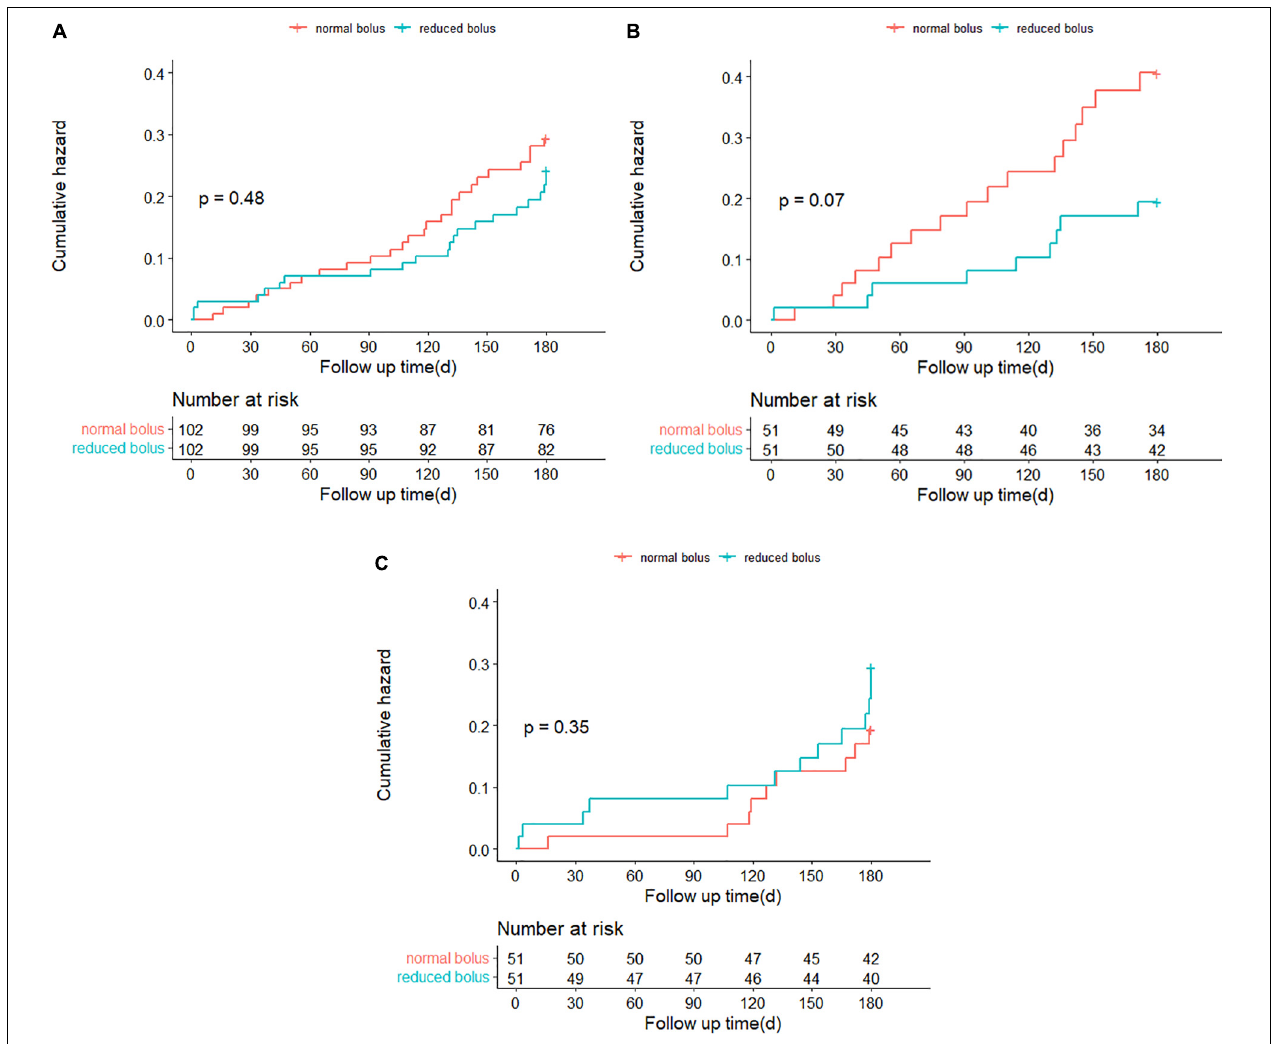
FIGURE 4 | (A) Time-to-event curves for the net adverse clinical events (NACEs) through 6-month follow-up. (B) Time-to-event curves for the NACE through 6-month follow-up in patients with normal eGFR. (C) Time-to-event curves for the NACE through 6-month follow-up in patients with abnormal eGFR.